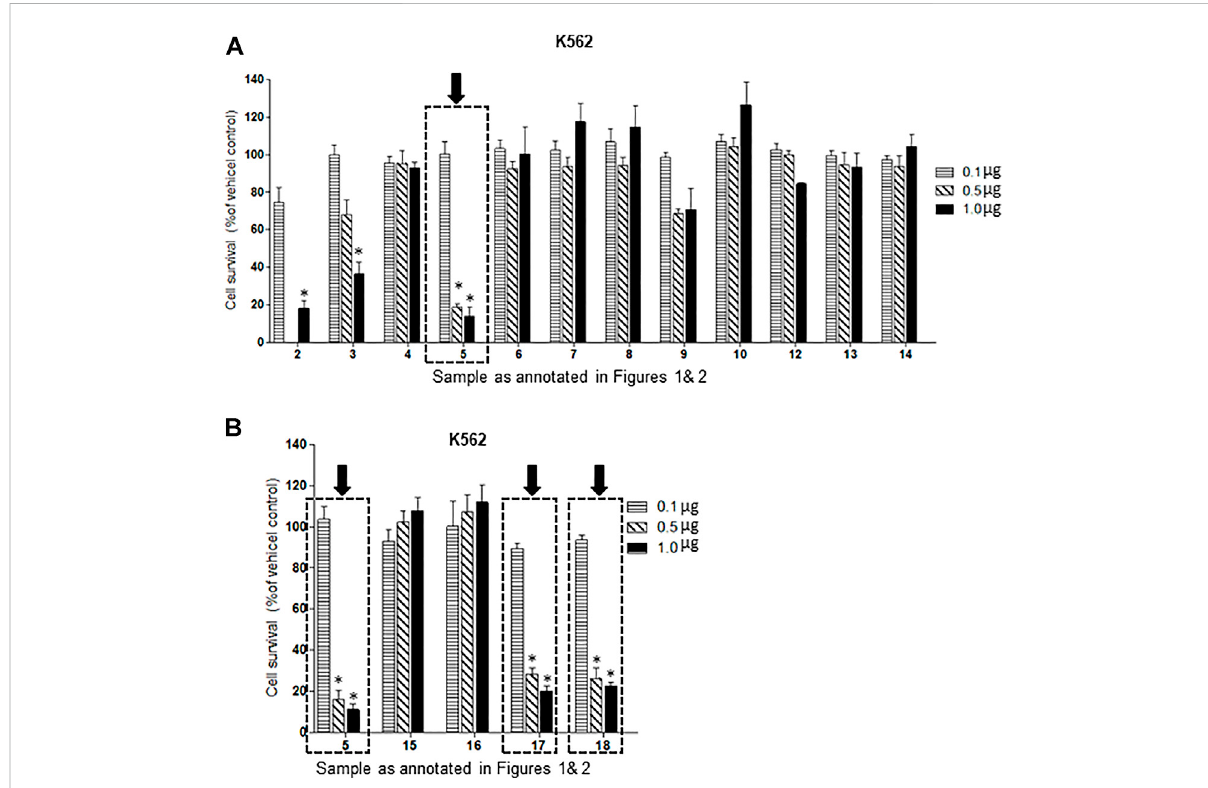
FIGURE 3 (A,B) : Dose-response comparison of the cytotoxic effects of various sterols (as % of ethanol vehicle control) shown to be present in EGS in this study on K562 CML, a human cancer cell line in vitro . The cell survival data presented as percentage of vehicle control determine the signi fi cant potency of triols #5, #17 and #18 in the tested cell line ( n = 3, p < 0.05, One-way ANOVA with Dunnett ’ s post-test to compare response of different